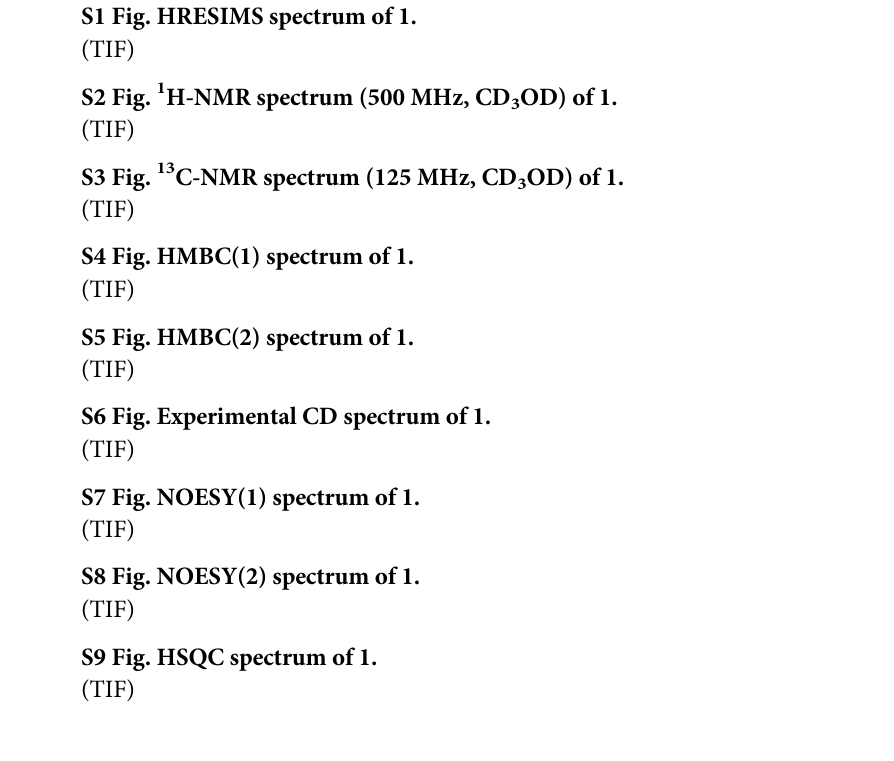
OD) of 1. 3 OD) of 1. 3